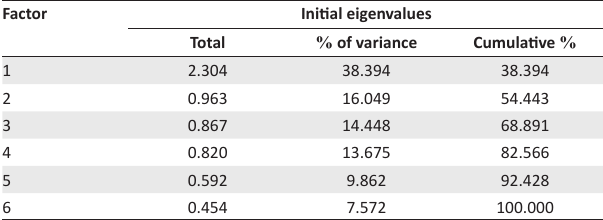
TABLE 7: Initial eigenvalues for human capital disclosure (second-level factor analysis). Factor